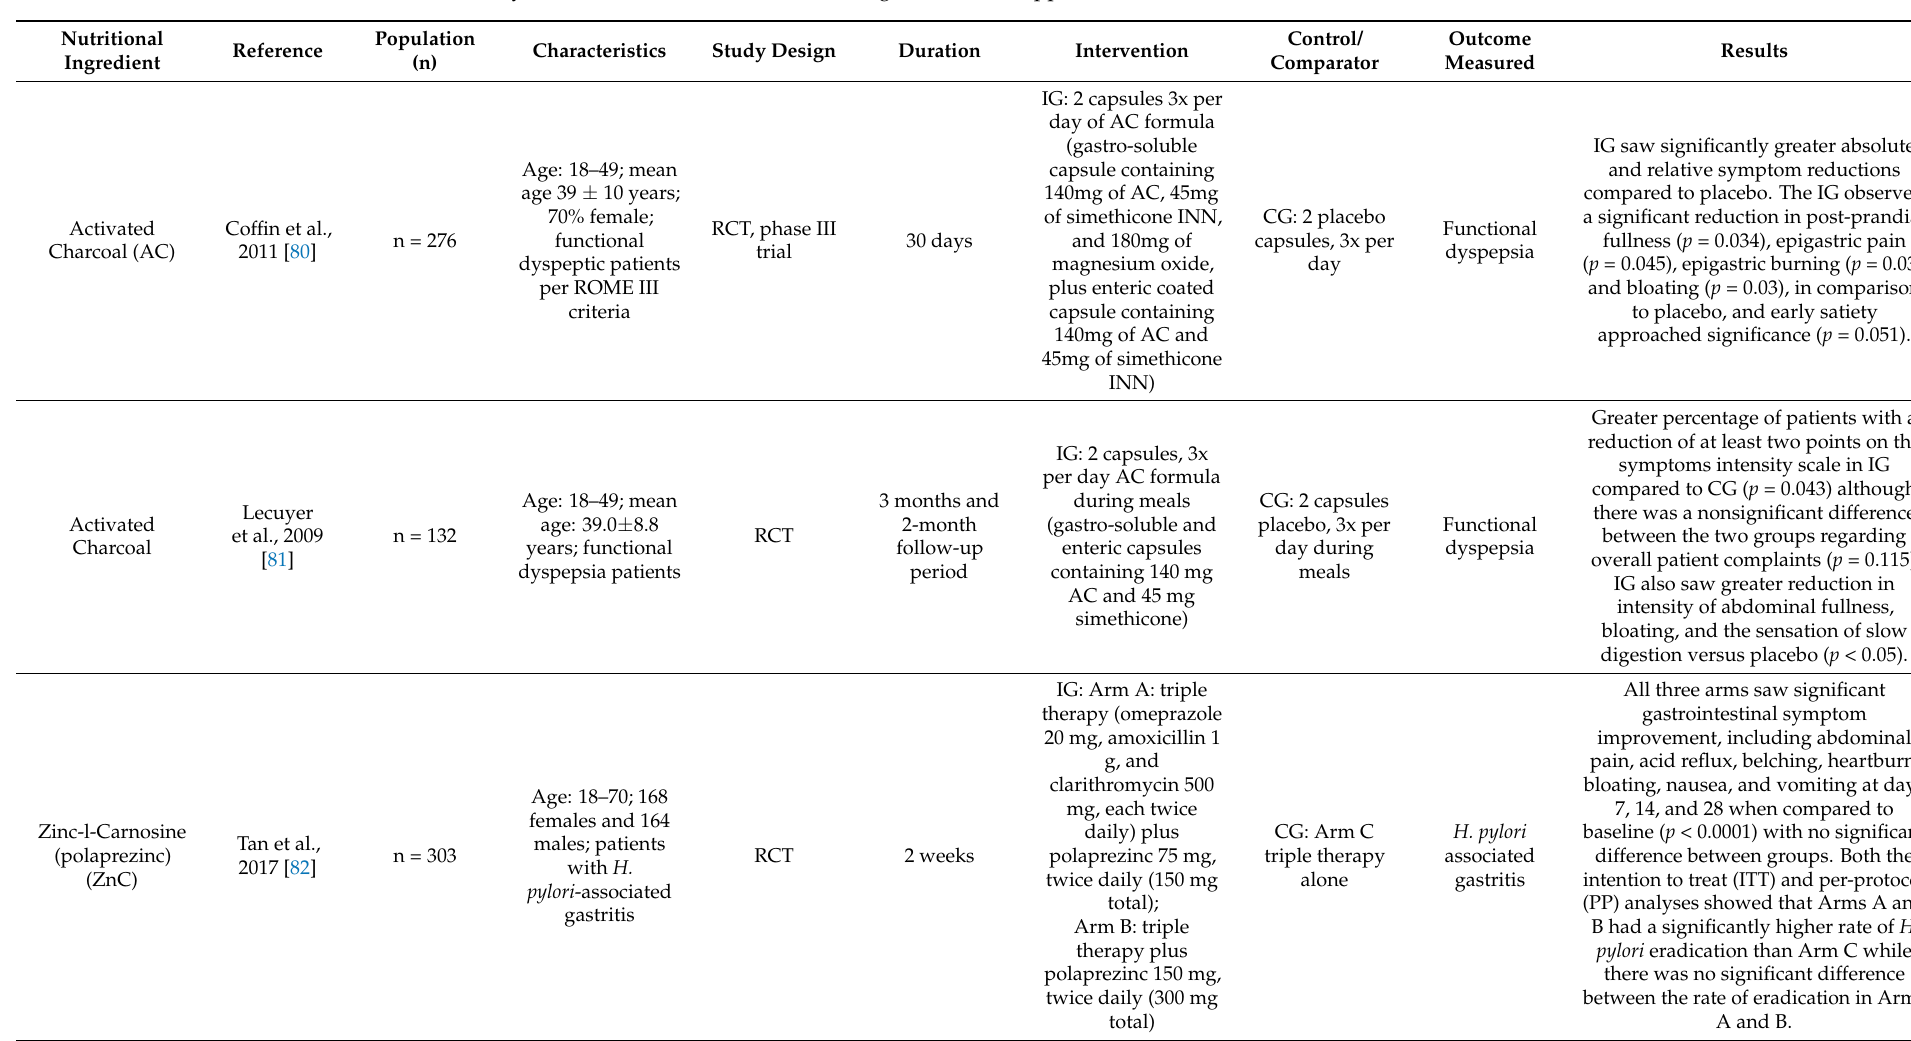
Table 7. Summary of human trials on non-botanical ingredients and upper GI